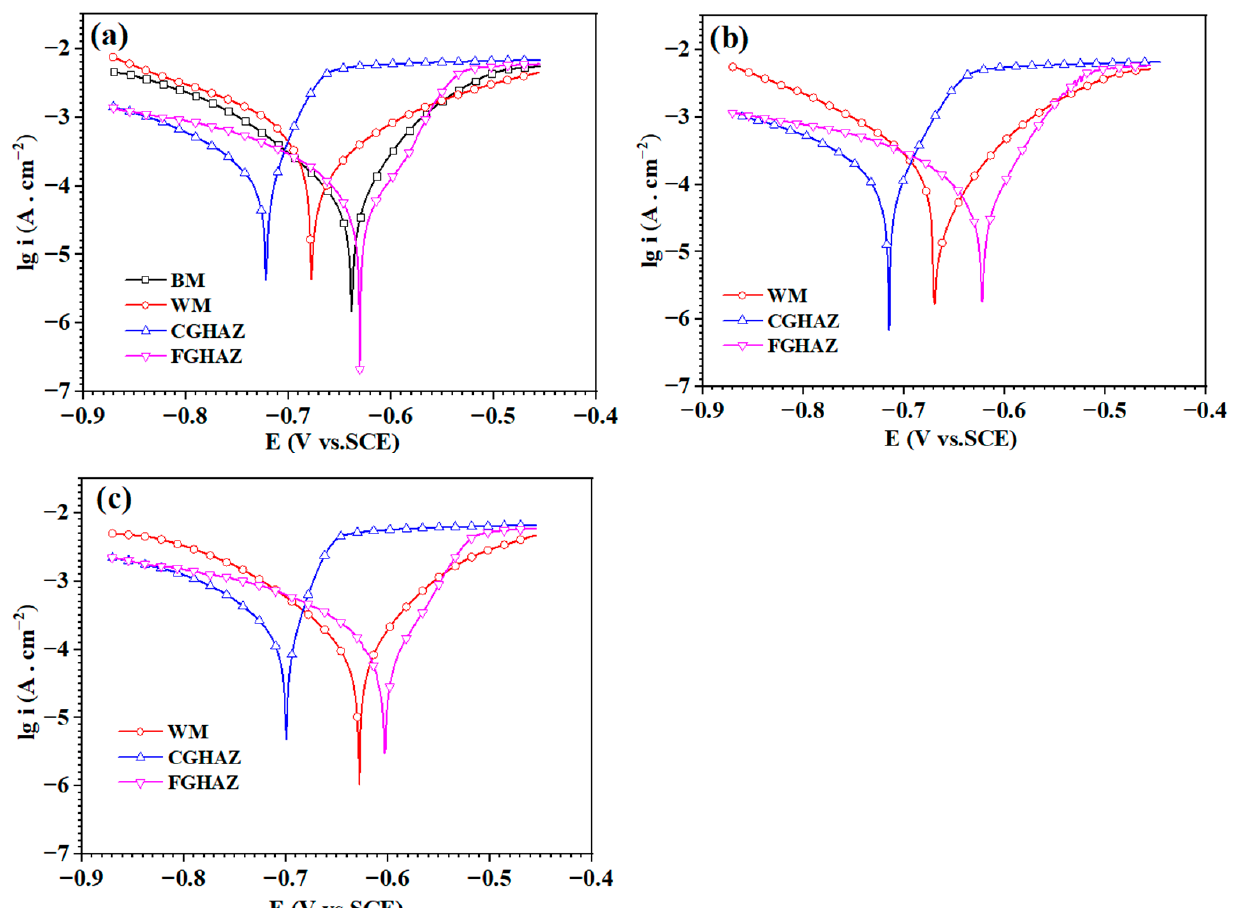
Figure 10. The potentiodynamic polarization curves of base material and fusion materials of laser welding with different heat inputs in NACEA solution with saturated H 2 S: ( a ) 2.86; ( b ) 4 and ( c ) 6.67 kJ/cm.